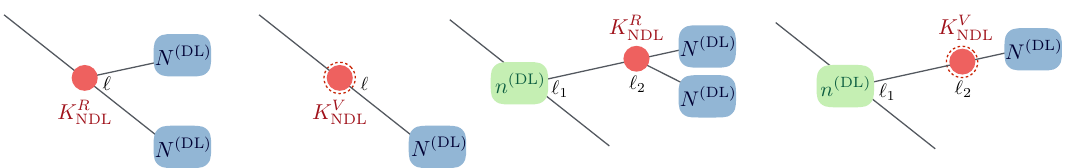
Figure 3. Sketch of the method used to compute NDL corrections from two basic ingredients: a single genuine NDL emission, the (red) solid vertex, and towers of DL emissions, either before (green box, eq. (3.12)) or after (blue box, eq. (3.10)) the NDL emission. The four diagrams represent